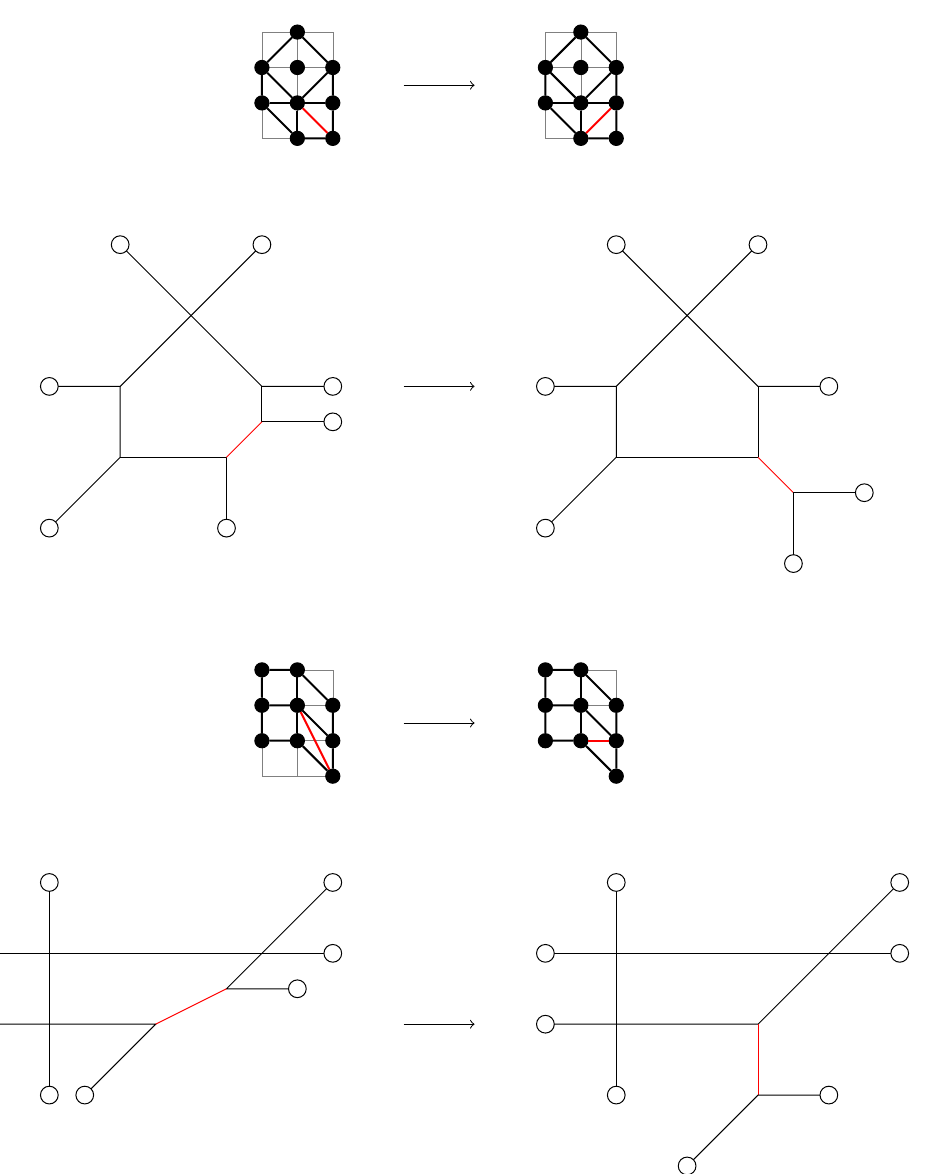
Figure 1 . Decoupling in a toric (top) and pGTP (bottom), as well as their counterparts in the brane-web. In each of the figures the left hand side shows the configuration before the flop, with the matter hypermultiplet “curve” shown in red, and the right hand side shows the configuration, after the